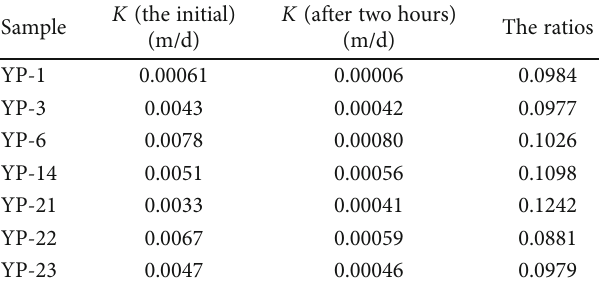
Table 3: The hydraulic conductivity in the saturated stage. Sample